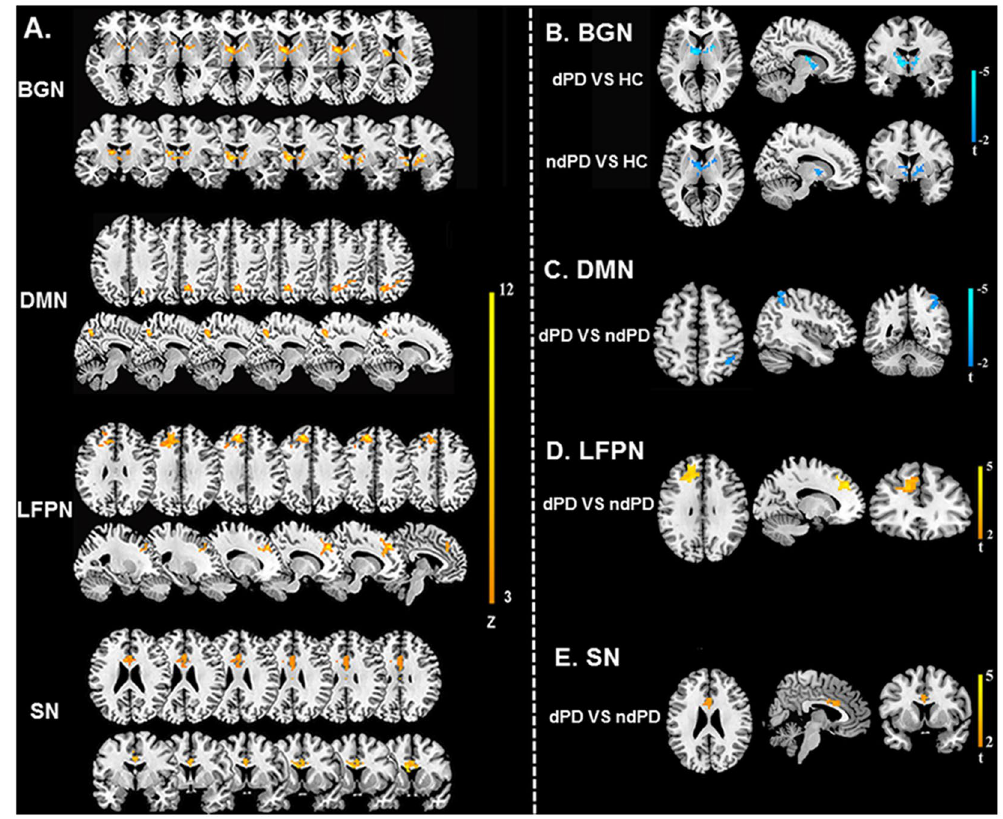
Figure 2. Inranetwork connectivity changes in dPD, ndPD and HC. ( A ) The ANOVA results for abnormal inranetwork connectivity among dPD, ndPD and HC groups (one-way ANOVA, p < 0.05, topoFDR corrected). ( B ), ( C ), ( D ) and ( E ) were the results for post-hoc comparison of inranetwork connectivity in dPD, ndPD and HC. ( B ) BGN showed decreased connectivity in dPD and ndPD by comparing with HC. ( C ) DMN displayed decreased connectivity in dPD compared with ndPD. ( D ) LFPN exhibited increased connectivity in dPD relative to ndPD. ( E ) SN showed increased connectivity in dPD compared to ndPD. Brian regions with cool (warm) color indicated significant decreased (increased) connectivity (two-sample post hoc t-tests, p < 0.05, topoFDR corrected).